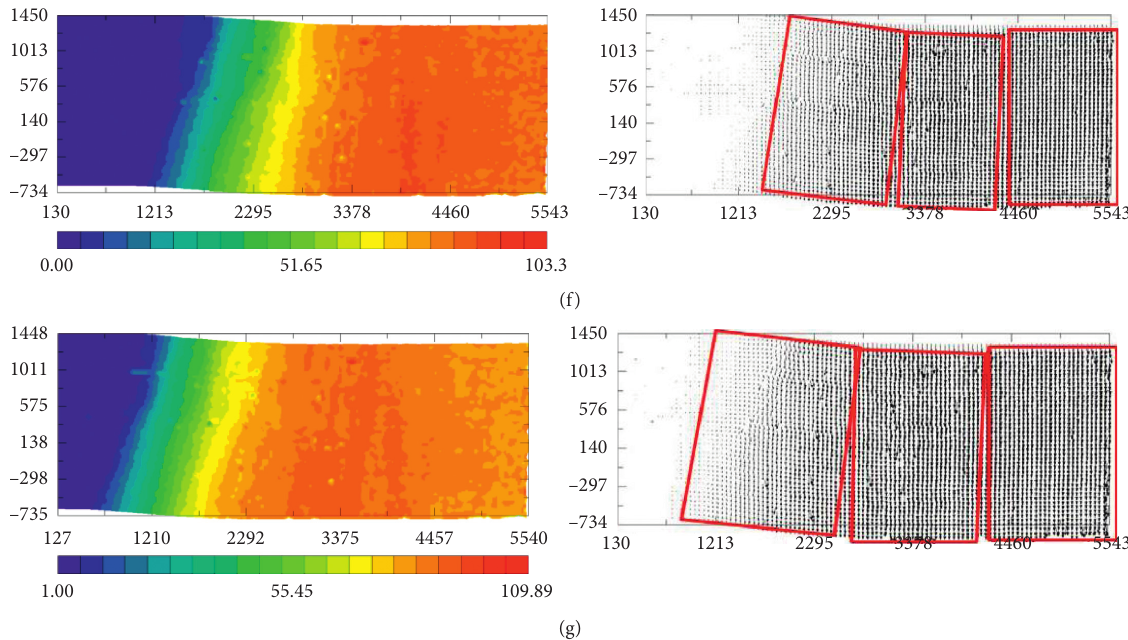
Figure 6: Displacement nephograms and vector diagrams of rock strata in the process of mining and filling of model I: (a) mining length 8m, (b) mining length 20m, (c) mining length 32m, (d) mining length 40m, (e) mining length 49m, (f) mining length 57 m, and (g) mining length